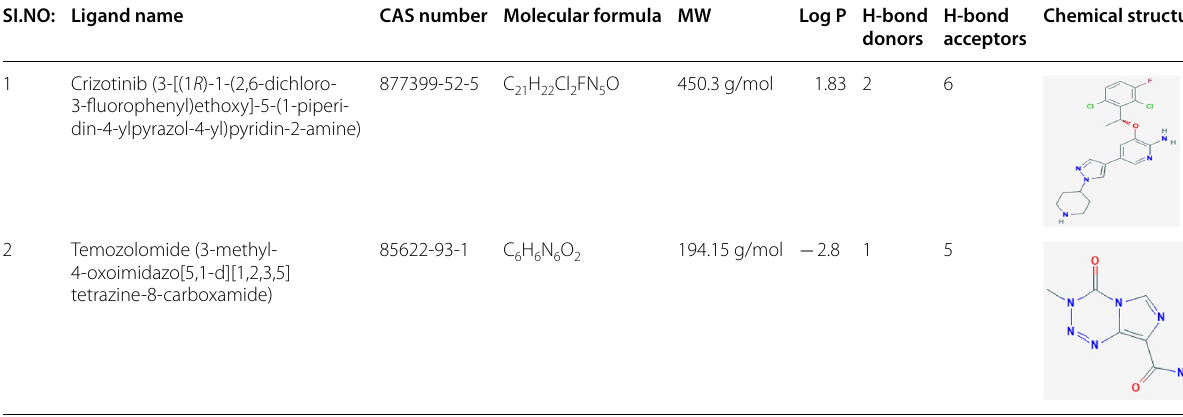
Table 1 List of ligands with CAS number which used for the study SI.NO: Ligand